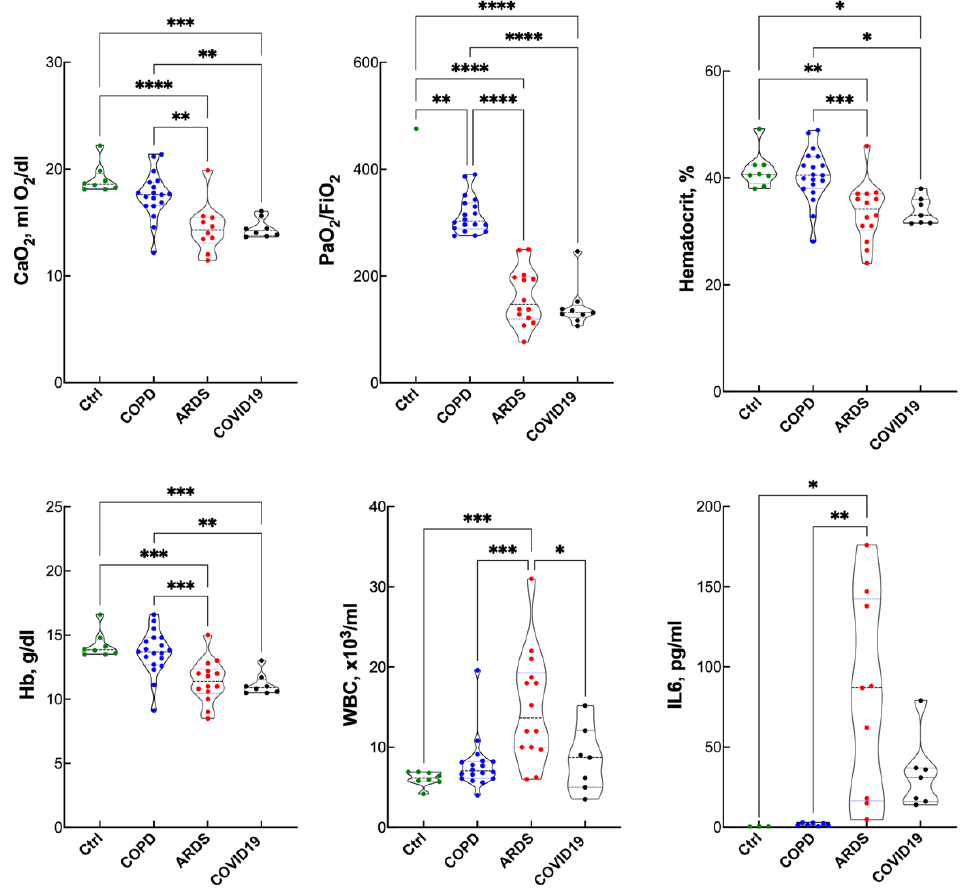
Figure 1. Hematopoietic, blood gas and inflammation data in controls, COPD, ARDS and COVID-19 (violin plots). Arterial blood gas analysis was not performed in Ctrl, and CaO 2 in Ctrl was estimated assuming PaO 2 = 100 mmHg. * p < 0.05; ** p < 0.01; *** p < 0.005, **** p < 0.0001 at the Tukey’s